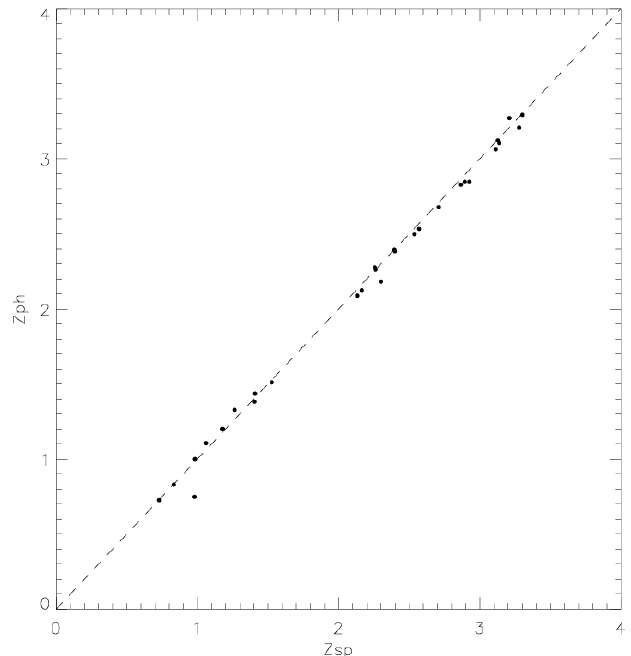
Figure 4. The accuracy of the photometric redshift determination from the medium-band photometry data. Along the vertical axis—the photometric redshift of quasars, along the horizontal—their spectroscopic redshift. σ = 0.02 [9].